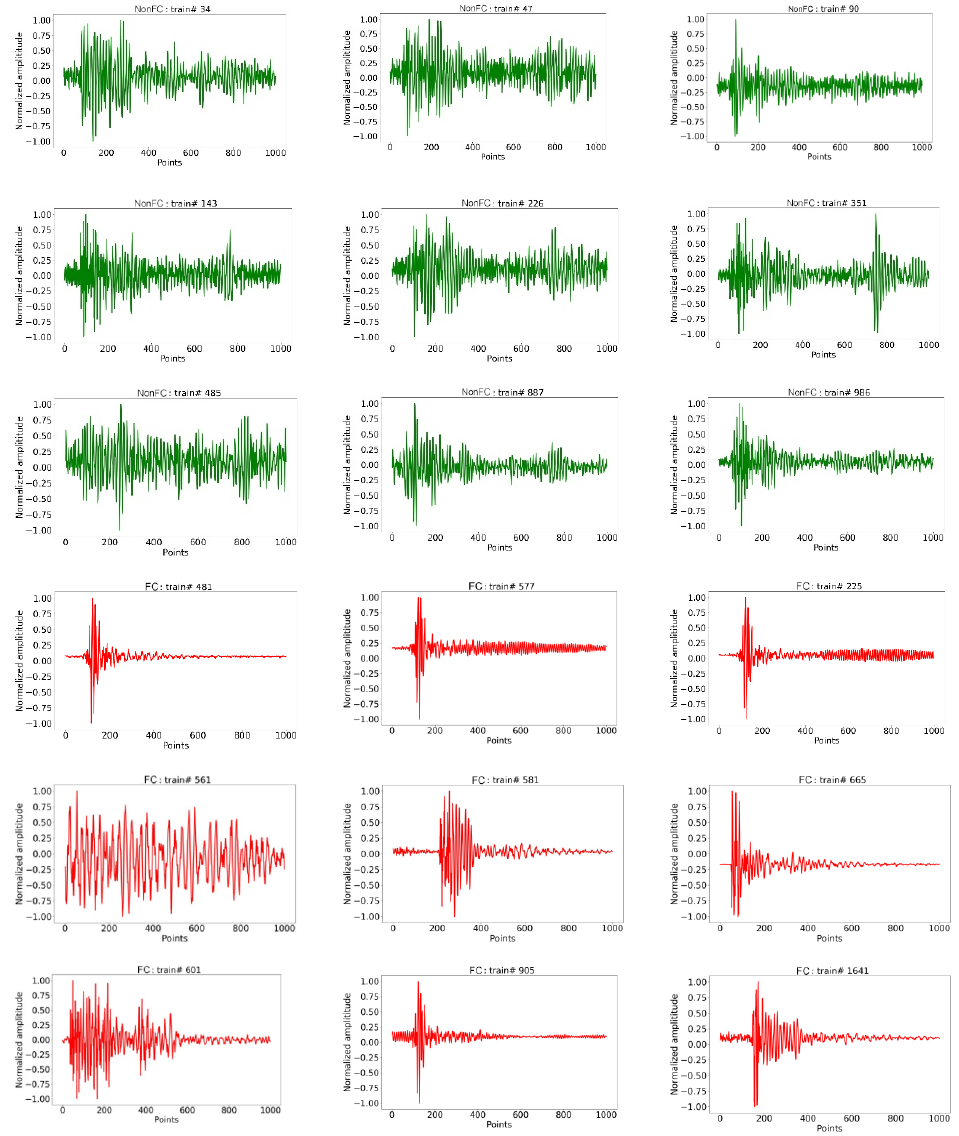
Figure 11. Some of the waveforms of FC, colored green, and those of NonFC, colored red.